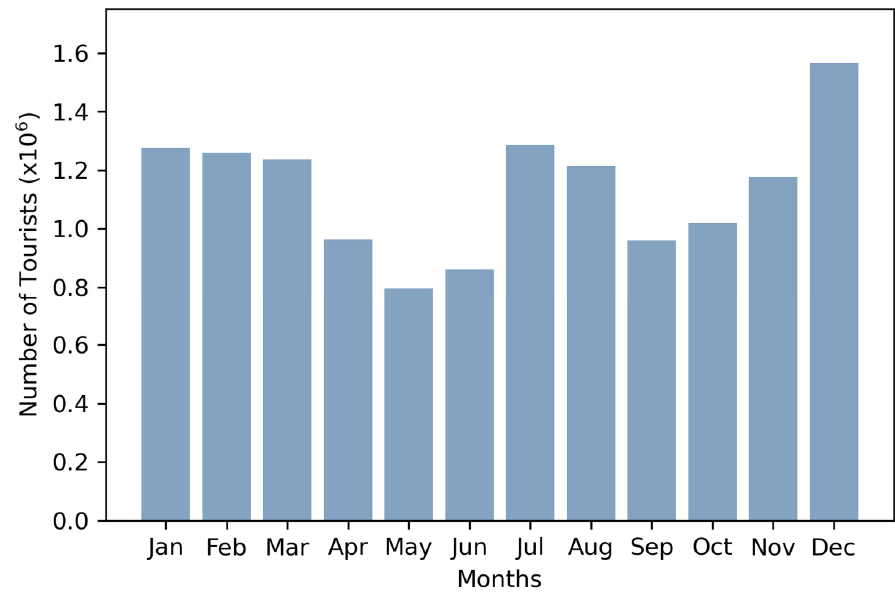
Figure 2. Monthly cumulative tourist arrivals from 2010 to 2018.